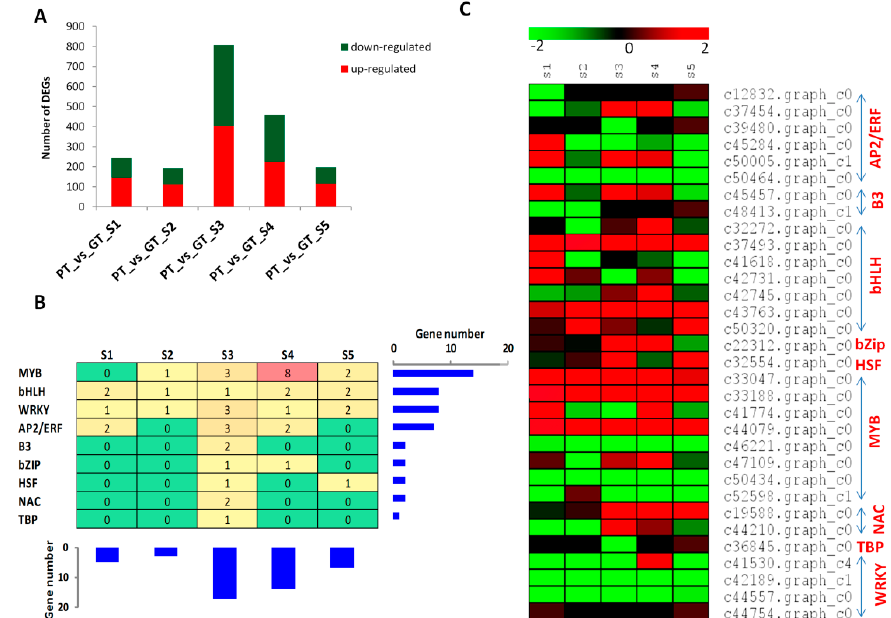
Figure 3. Transcription factors (TF) regulating the gene expression between the two turnips. ( A ) Number of up- and down-regulated genes between PT and GT at different developmental stages S1-S5. PT represents the purple turnip while GT represents the green turnip; ( B ) overview of the enriched TF family. The combined histograms showed the number of occurrence of genes belonging to each TF family or at each developmental stage; ( C ) Heatmap displaying the expression fold change (Log2 fold change) between PT and GT for the gene encoding transcription factors.